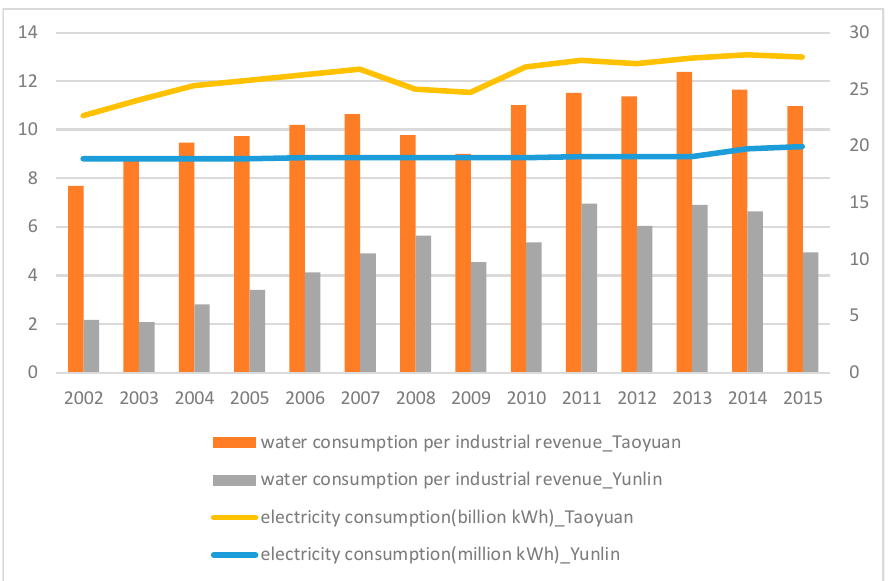
Figure 3. Water consumption per industrial revenue (million m 3 , left scale) and electricity consumption (billion in Taoyuan, million in Yunlin, right scale) in Taoyuan and Yunlin, 2002–2015.